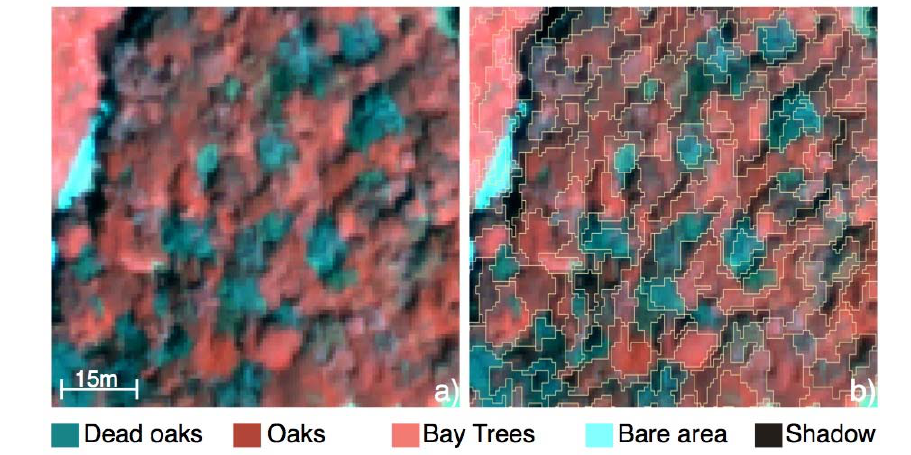
Figure 2. The first step of the OBIA process: the image segmentation process: (a) a fine spatial resolution color infrared image of an oak forest stand with dead trees; (b) the corresponding image